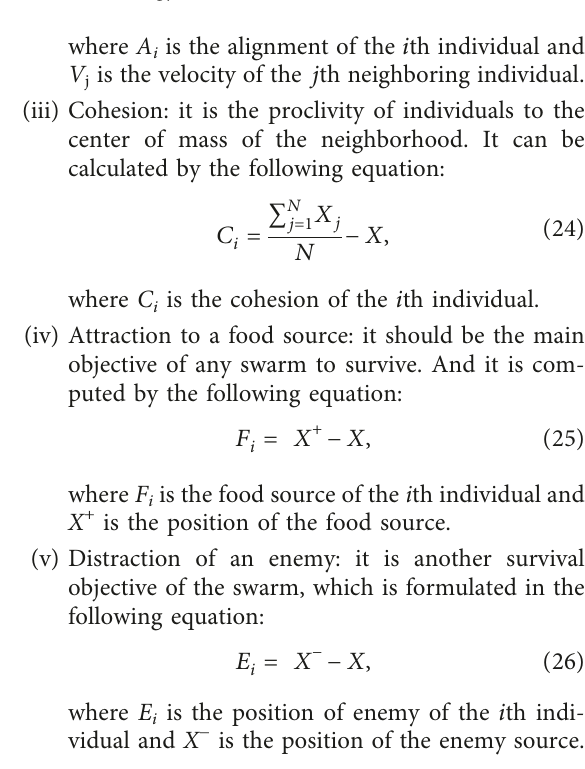
Figure 2: The schematic of a few functions performed in the energy control center